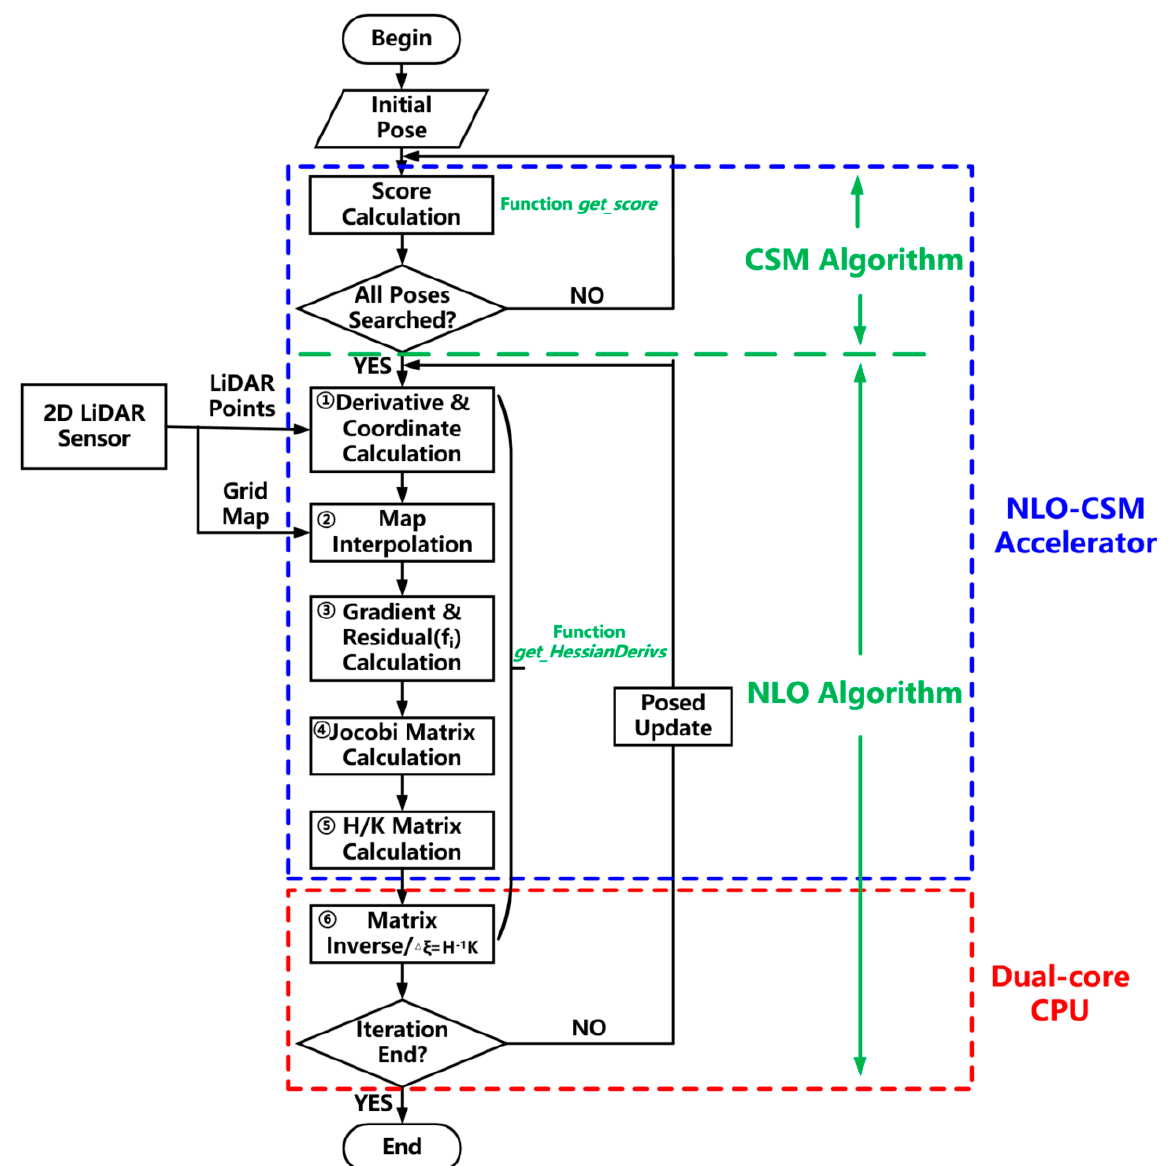
Figure 5. Flow chart of the NLO-CSM algorithm and the corresponding software and hardware design partition.